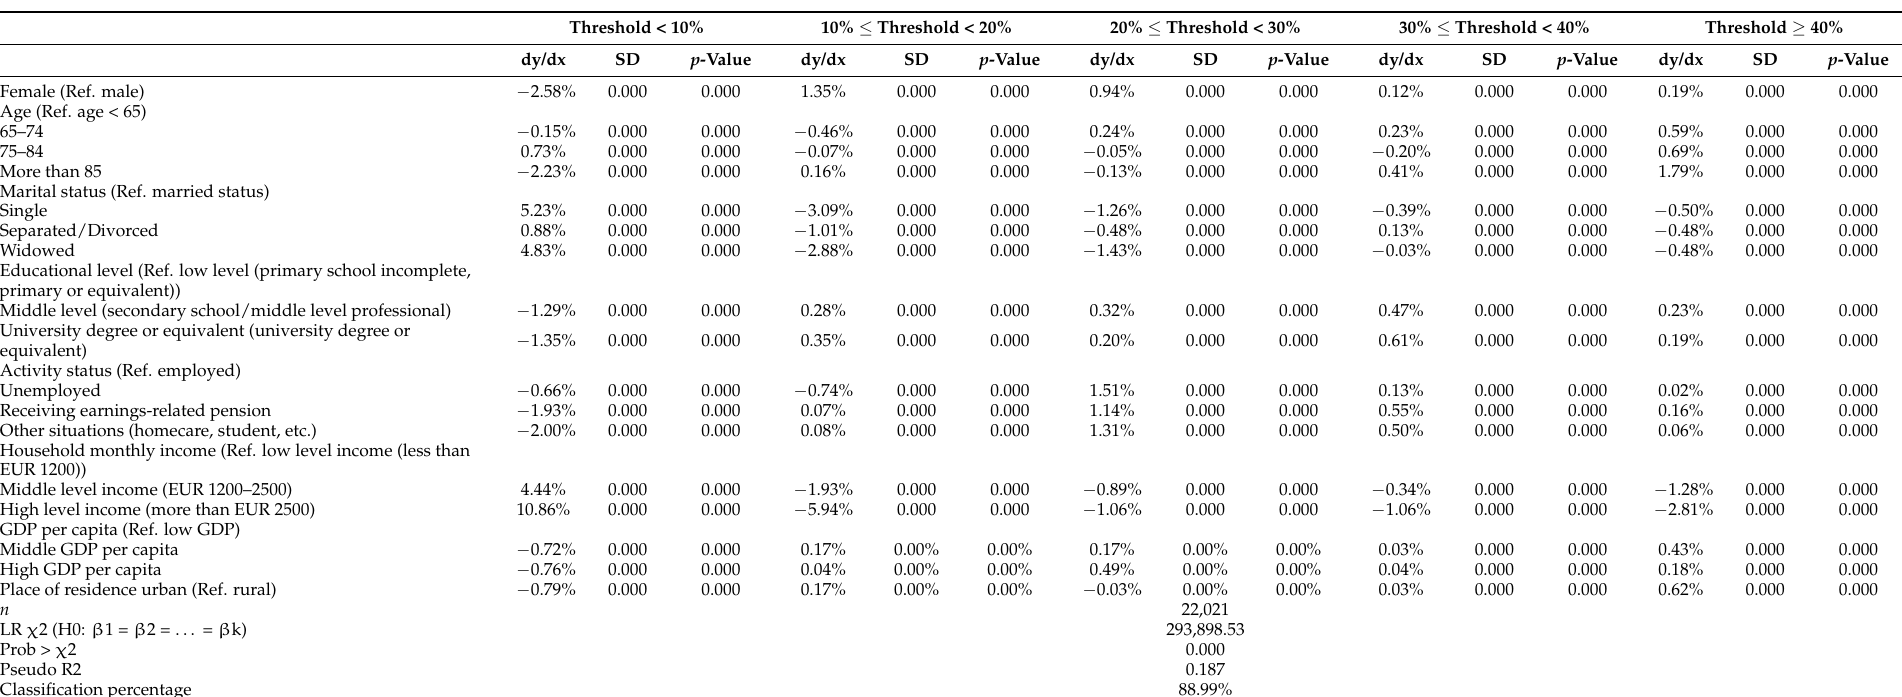
Table 5. Marginal effects of the sociodemographic factors of households in Spain associated with financial catastrophism derived from out-of-pocket payments in health in Spain. Year